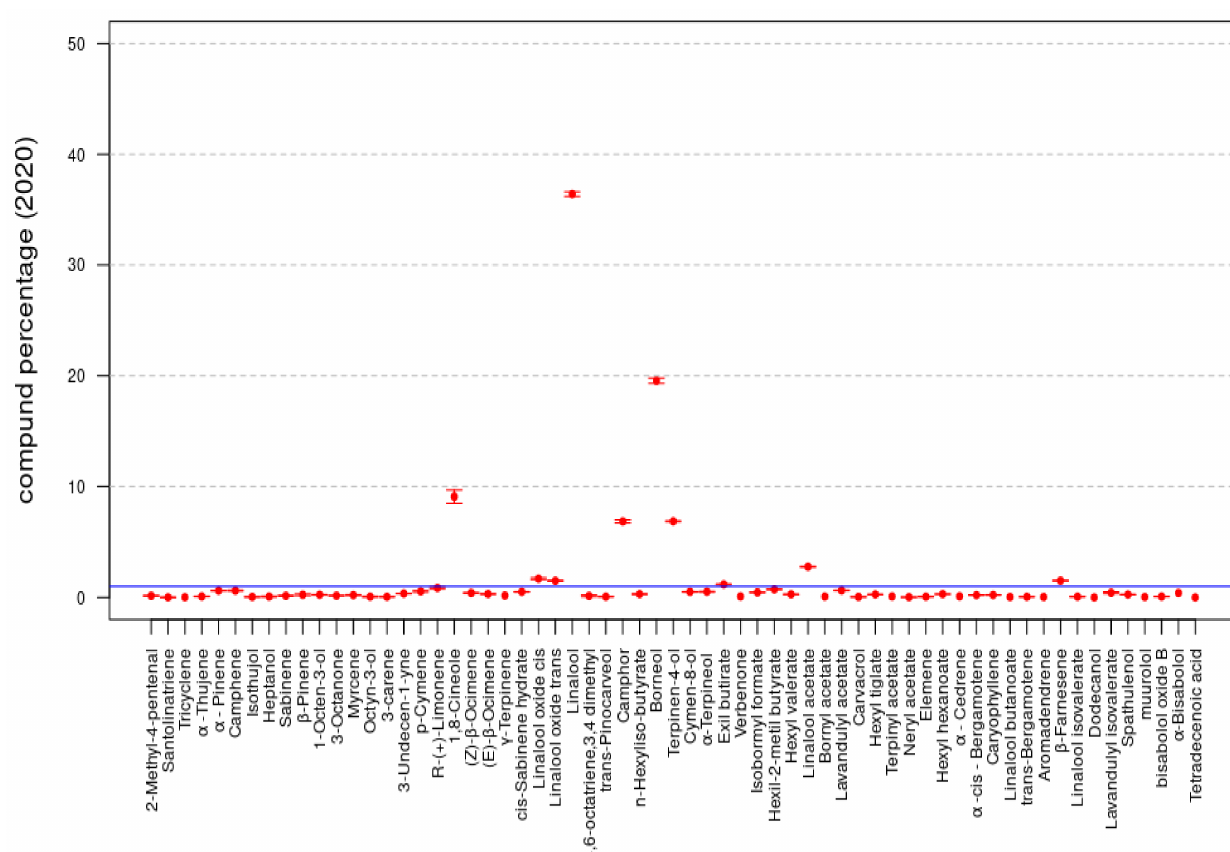
Figure 2. Compound percentages, mean ± SD, LA 2019 EO.